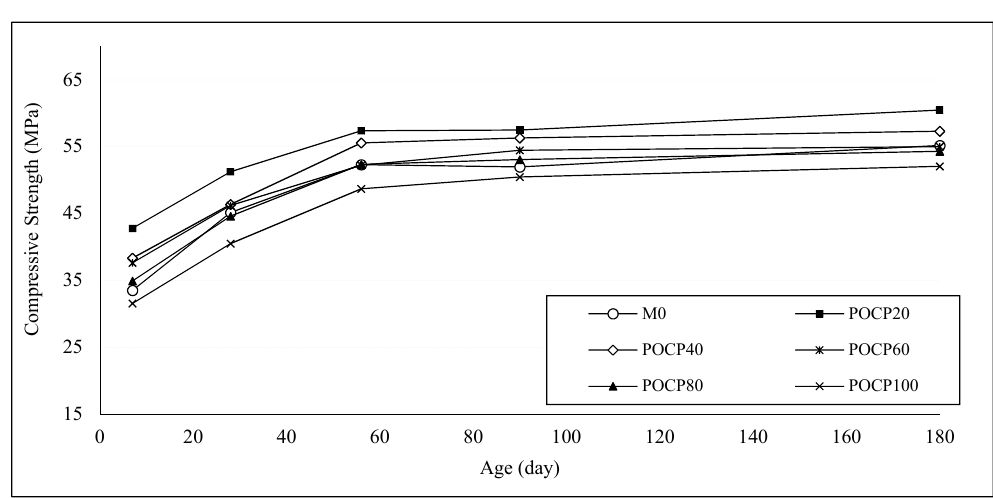
Figure 12. Development of POCP concrete strength. Coatings 2017 , 7 , x FOR PEER REVIEW